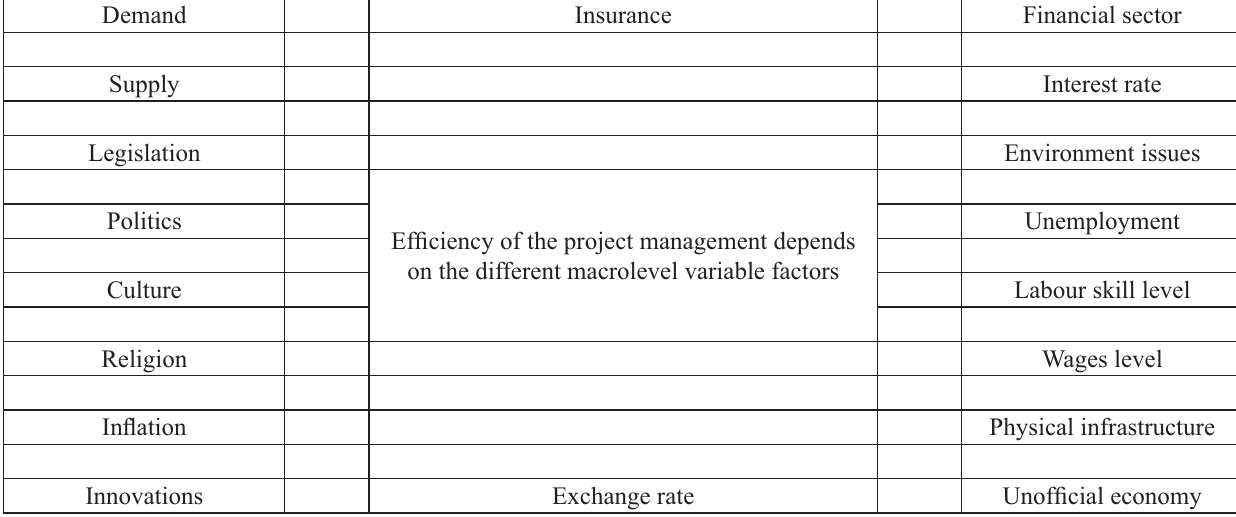
Fig. 1. Effi ciency of the project management depends on the different macrolevel variable